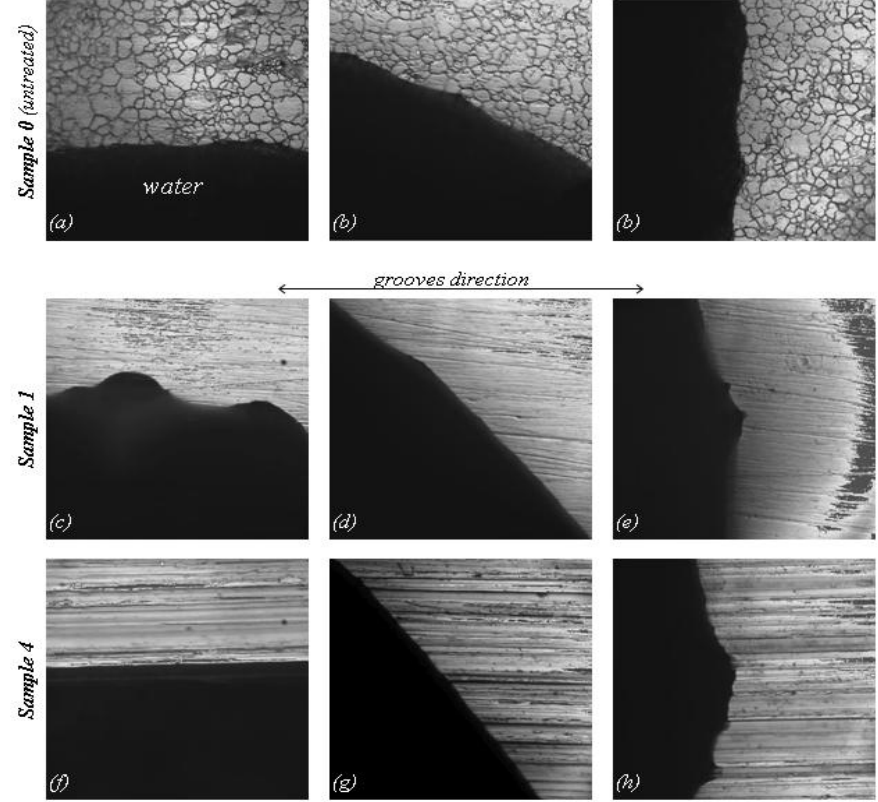
Figure 6. Effect of topographic anisotropy of stainless steel on the water drop boundary at different locations. The measured side length of all the images is 160µm